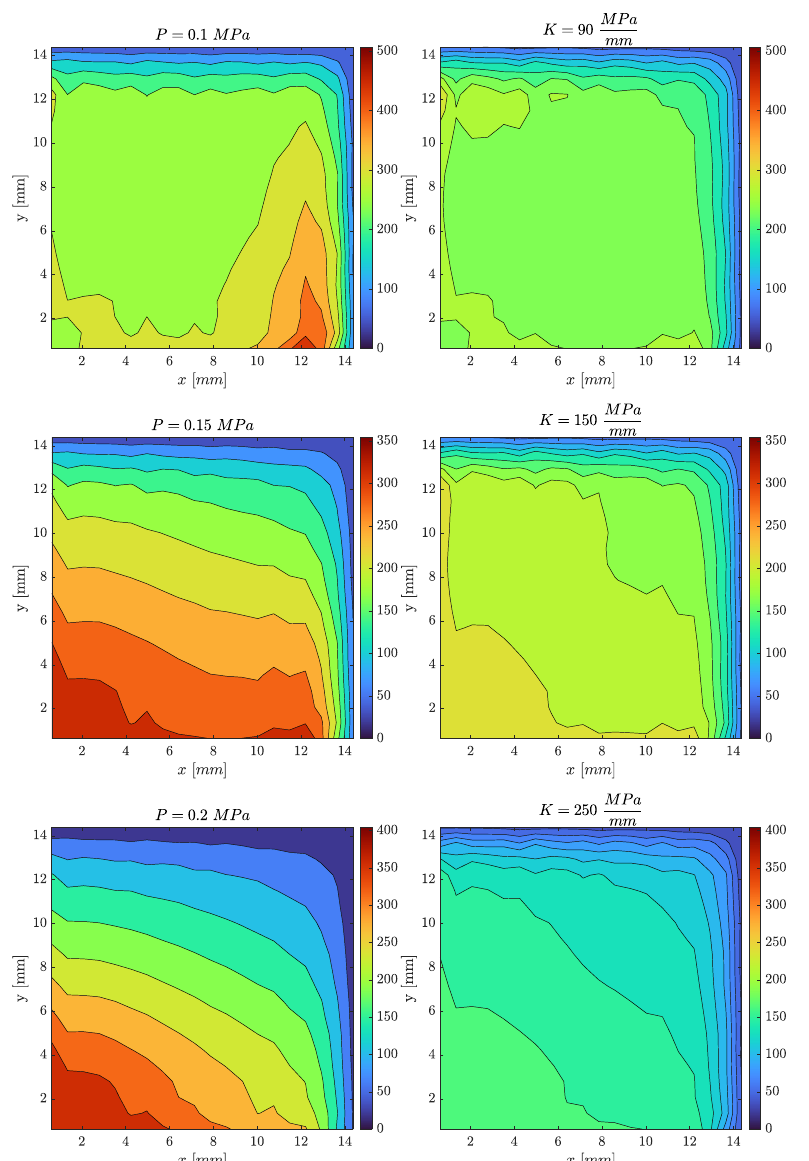
Figure A2. Complete thermal contact resistance R TC [ ◦ Cmm 2 /W] distribution comparison in the potential contact zone for the uniform clamping pressure and Winkler elastic